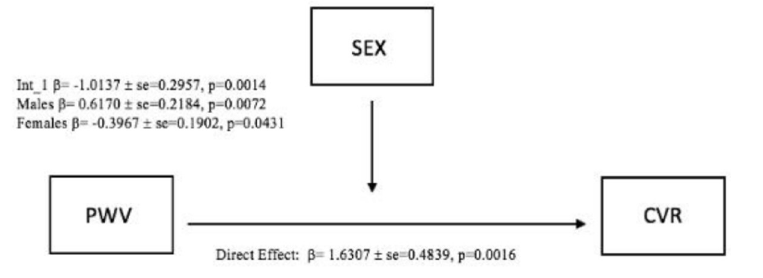
Fig 1. Moderation effect (PWV � SEX) on